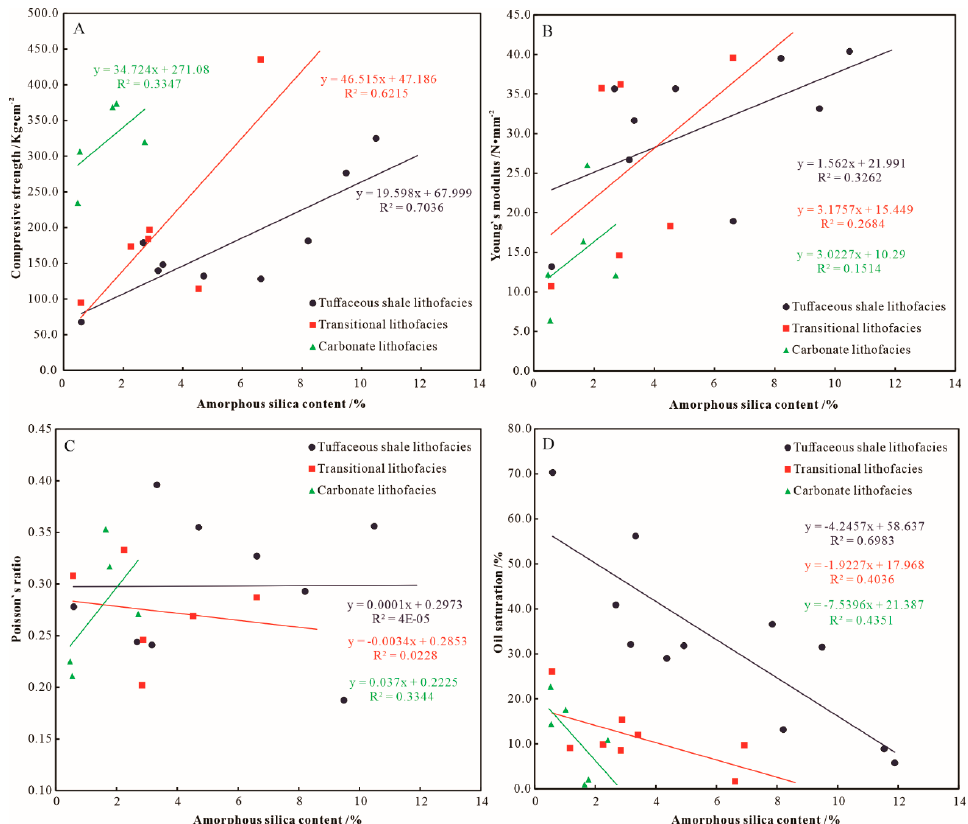
Figure 6. Cross plot of amorphous silica content with ( A ) Young’s modulus, ( B ) Poisson’s ratio, ( C ) compressive strength and ( D ) oil saturation of different lithofacies in Lucaogou Formation.